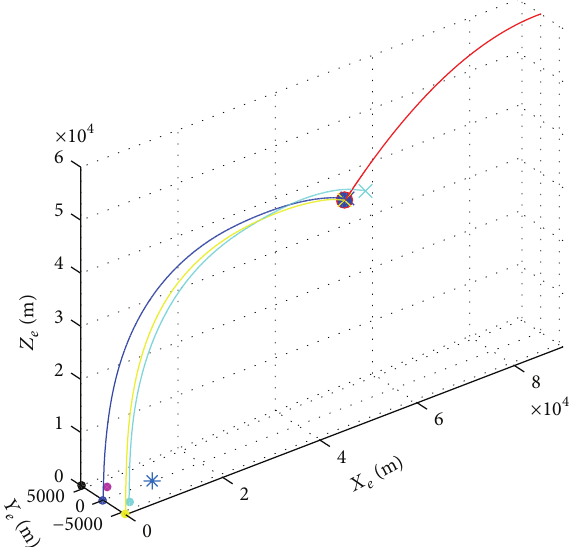
Figure 9: Interception of a low altitude-high velocity ballistic target. Red line depicts the trajectory of the ballistic target. Algorithm launches 3 missiles to intercept the target.